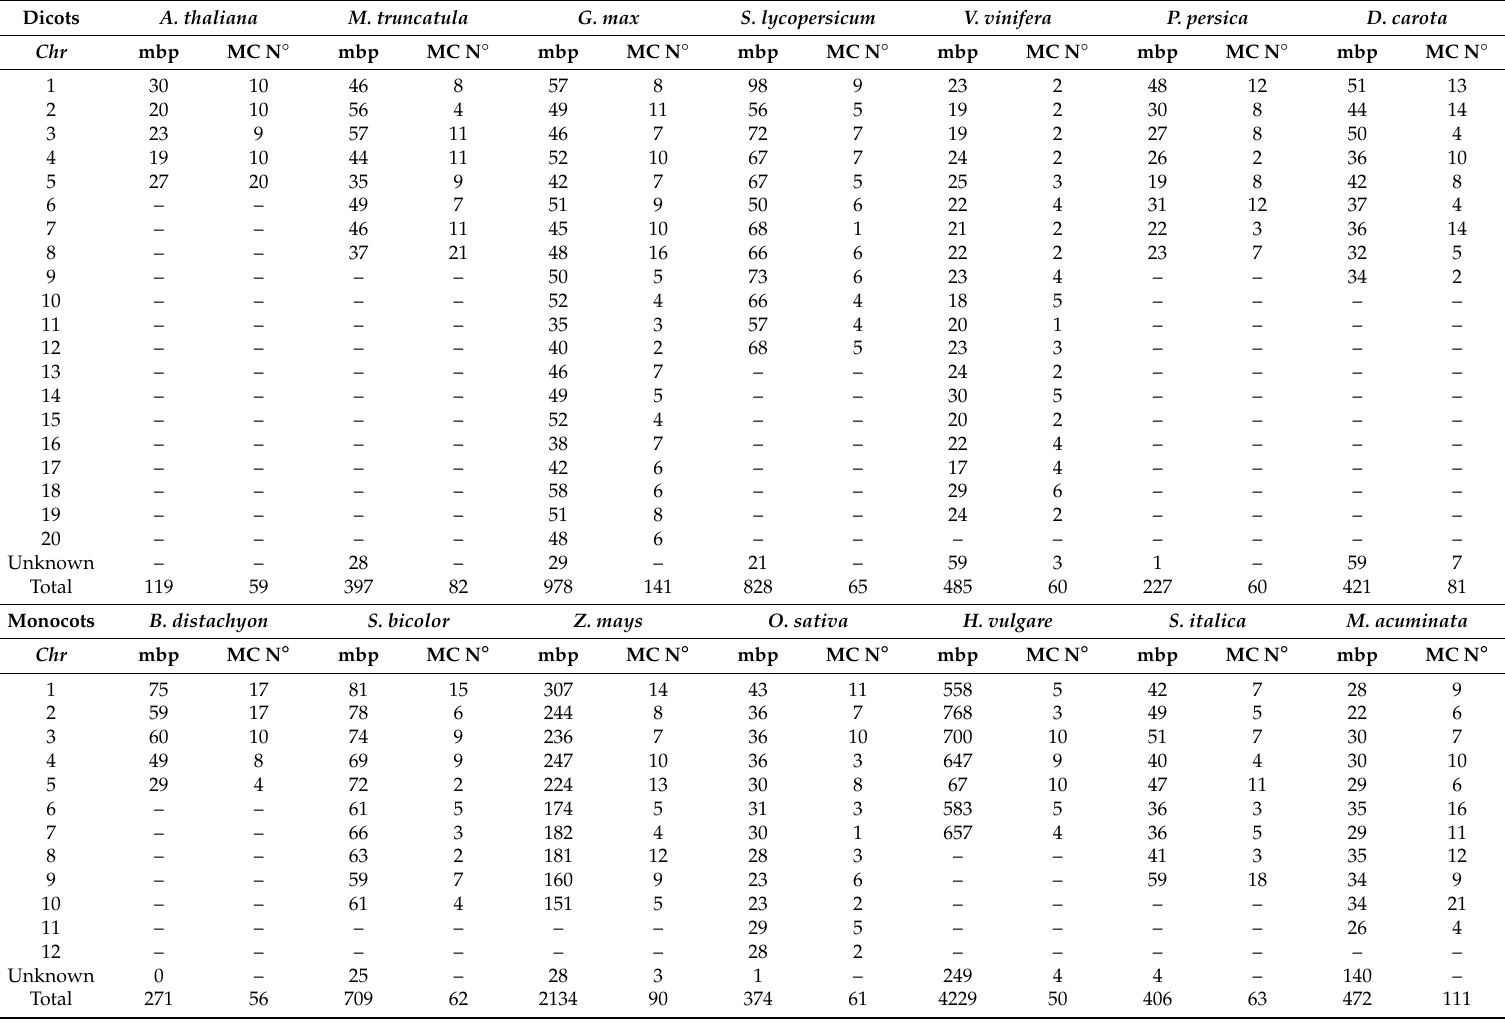
Table 1. Mitochondrial carriers (MCs) present in each chromosome of plant genomes recently